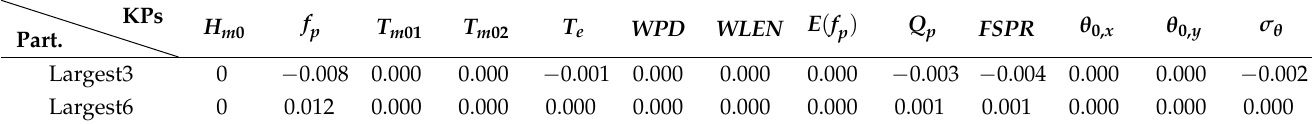
Table 7. Correlation coefficient (R) of the KPs derived from the original and the reconstructed spectra (with the three and six largest partitions) at check point B2. The values of R are expressed as the differences to those obtained from the original spectra and the reconstructed ones using the four largest partitions.